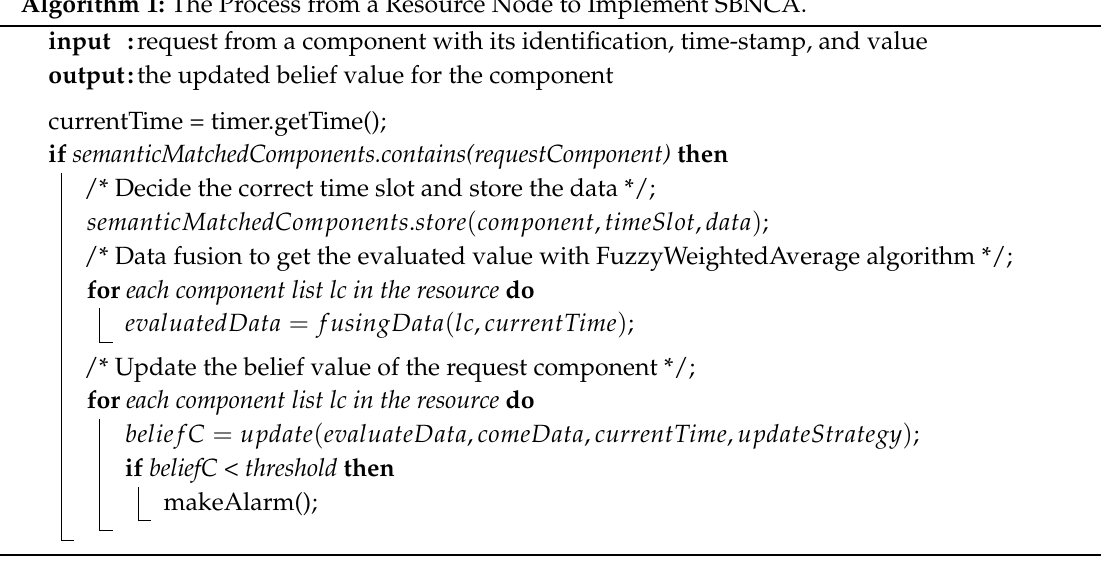
Algorithm 1: The Process from a Resource Node to Implement